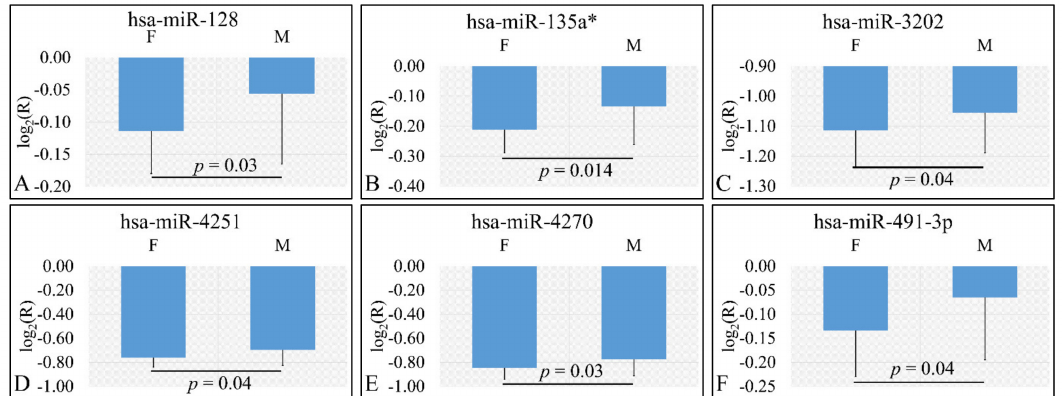
Figure 2. DE miRNAs with respect to gender ( n males = 39, n females = 25). DE miRNAs included miR-128 ( A ), miR-135a* ( B ), miR-3202 ( C ), miR-4251 ( D ), miR-4270 ( E ), miR-491-3p ( F ). All miRNAs presented include those that are significantly different between male and female children (Legend: DE: Differentially expressed, R: Relative expression, where R = E tumors and E is the expression levels of controls and tumors respectively, M: Male, F: